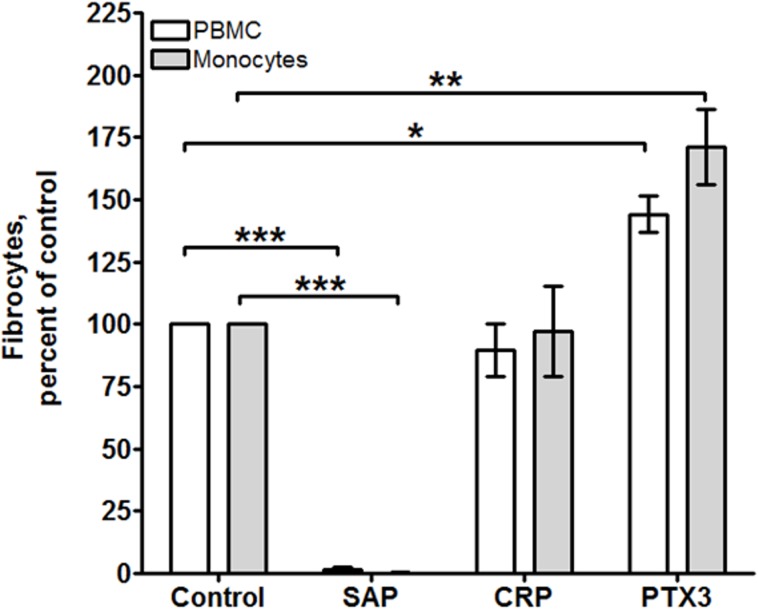
PTX3 acts directly on CD14+ CD16- (FcγRIIIA) monocytes.PBMC and isolated CD14+ CD16- monocytes were incubated for 5 days in the presence or absence of 1 μg/ml SAP, CRP, or PTX3. After 5 days, cells were air-dried, fixed, and stained, and the number of fibrocytes was counted. Values are mean ± SEM (n = 3). *p <0.05; **p <0.01; *** <0.001 (ANOVA).